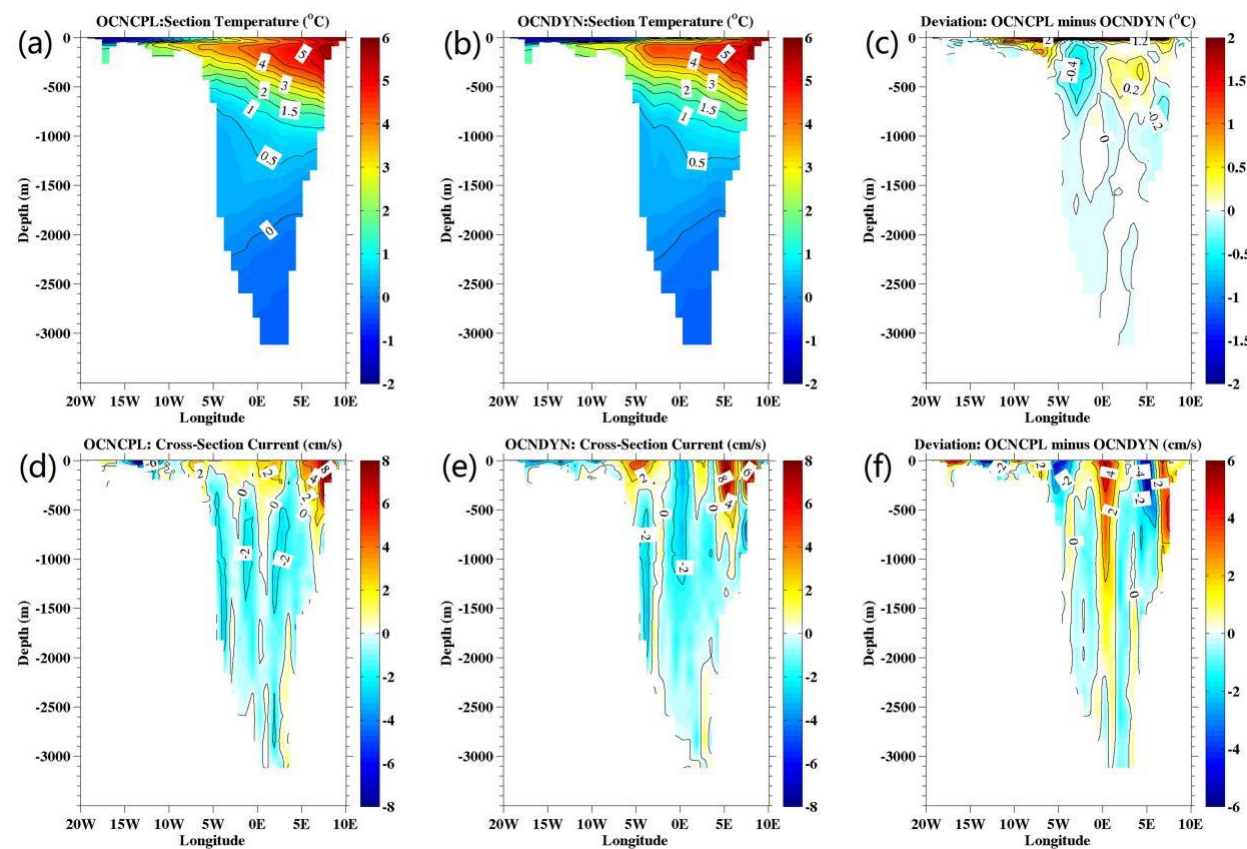
Figure 16. July–August–September mean ocean temperature and meridional velocity section along 78 ◦ N in Fram Strait. The top and bottom panels show the ocean temperature and meridional velocity, respectively. The left, middle and right panels show the OCNCPL run, the OCNDYN run and the deviation between them,